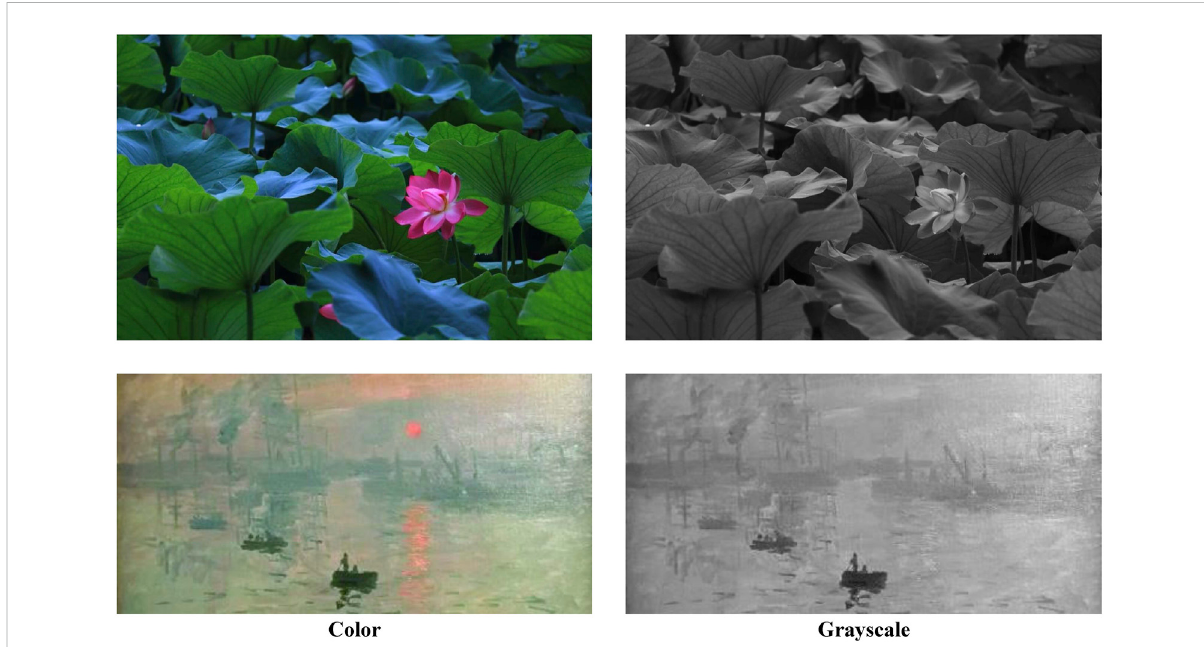
FIGURE 1 Visual comparisons of color images and gray-scale images of the same content. In the images in color mode, objects (lotus and sun) exhibit a pop-out effect due to their distinguishable color, while in gray-scale mode, the guiding power of these objects is almost the same as the rest of the surroundings, and this information has little effect on visual